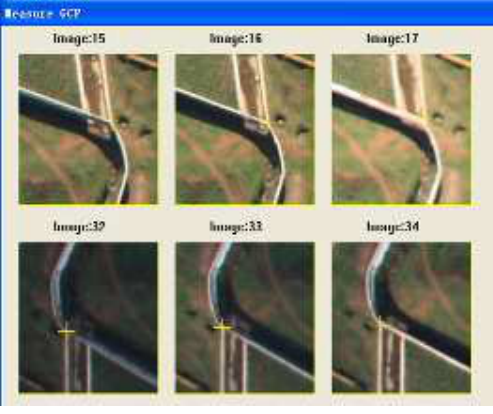
Figure 5 Measuring GCP in